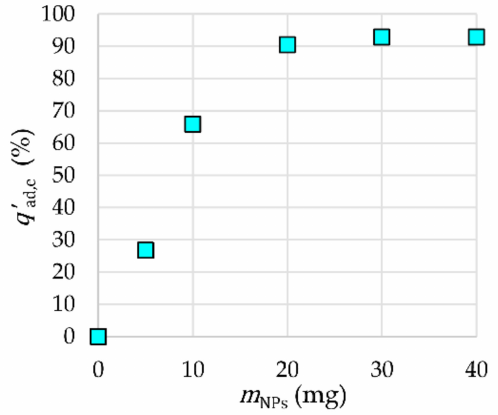
Figure 10. Influence of the mass of NPs on adsorption e ffi